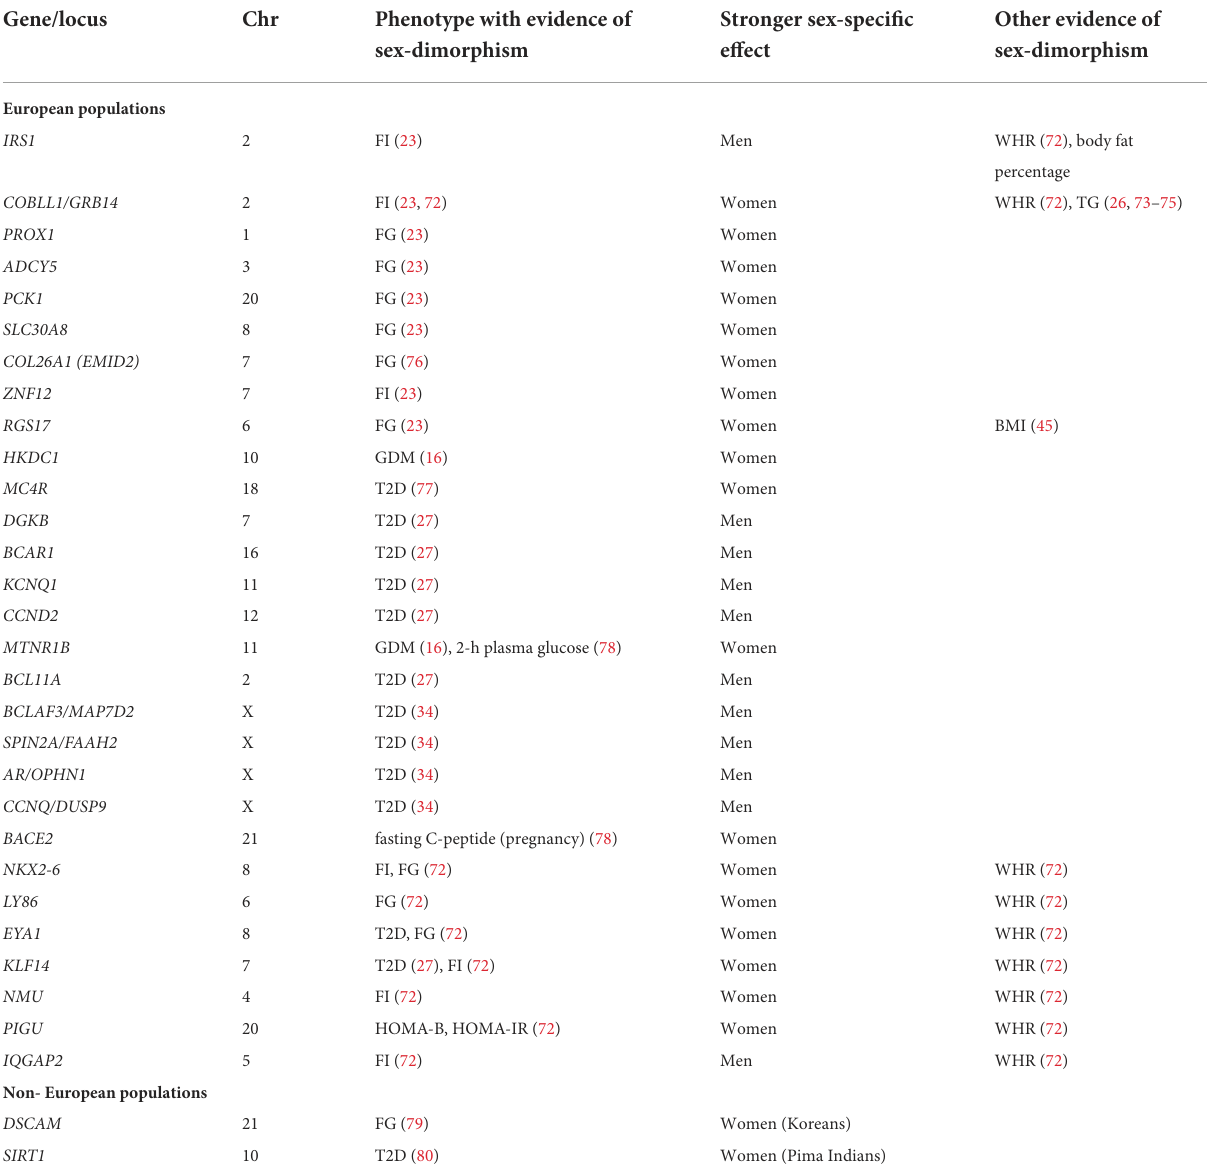
Stronger sex-specific Other evidence of effect sex-dimorphism